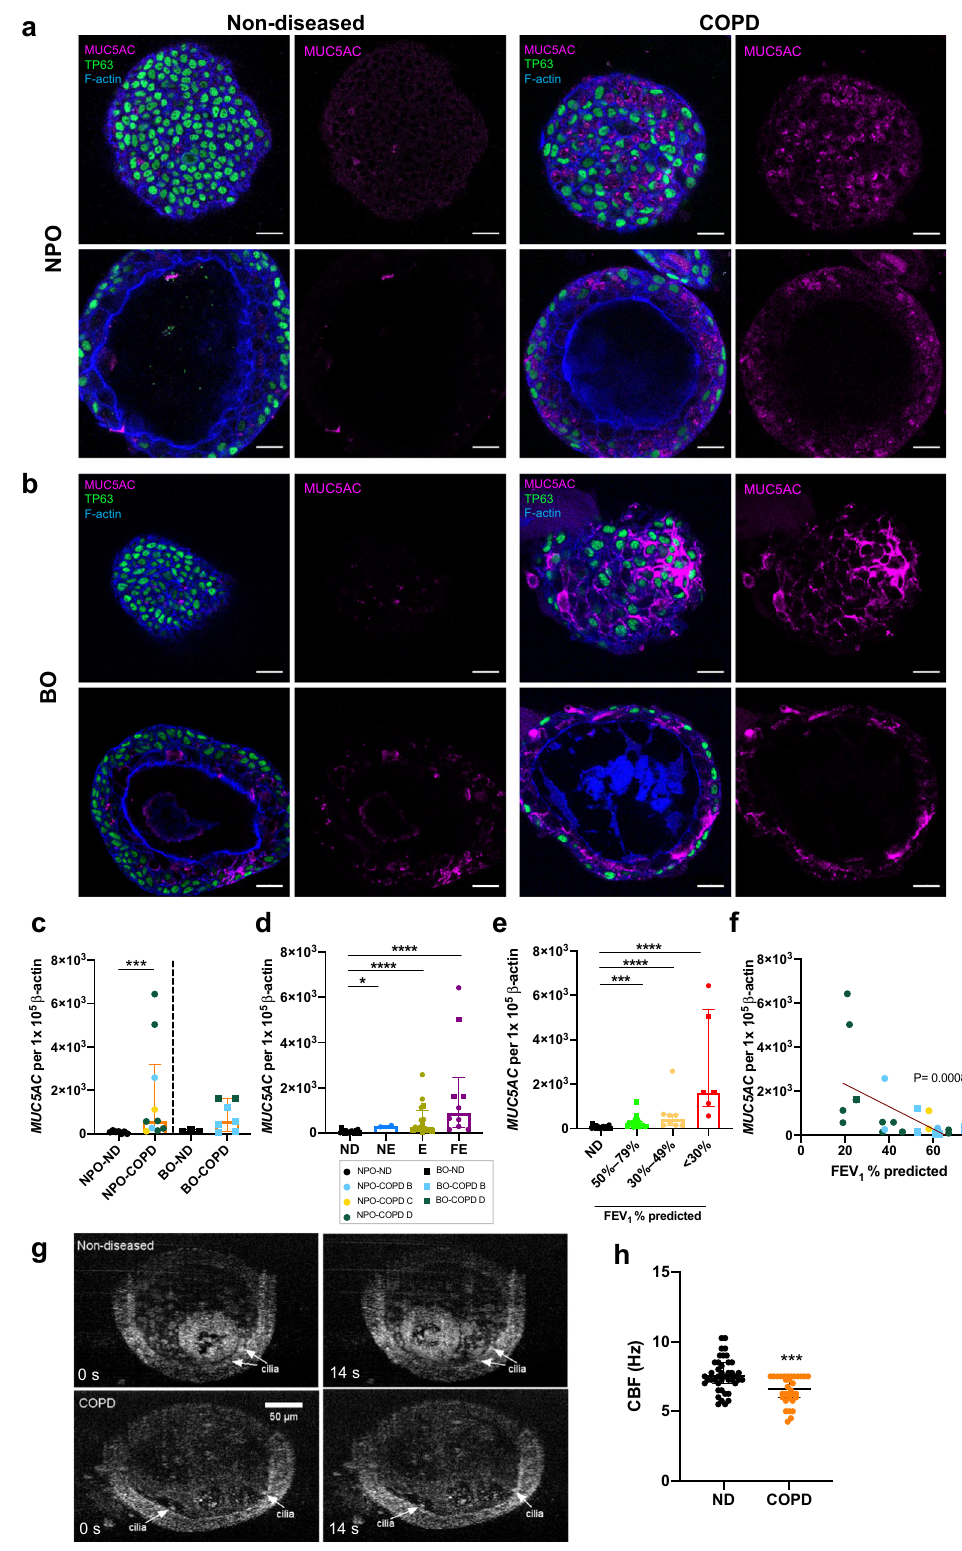
CXCL10 revealed no differences between the NPOs and BOs fol- lowing L-WU infection with and without COPD. However, infection with G-614G demonstrated a signi fi cant reduction in IL-6 and IFN- β in the lower COPD airway with a trend toward inhibition of CXCL10 when compared to non-diseased individuals (Fig. 5e –